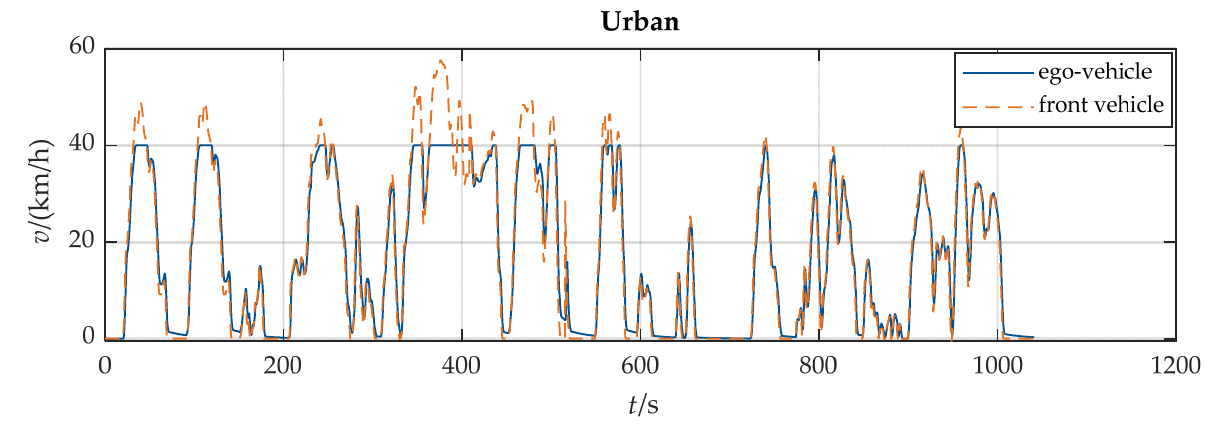
Figure 17. Urban cycle for the safe driving style.